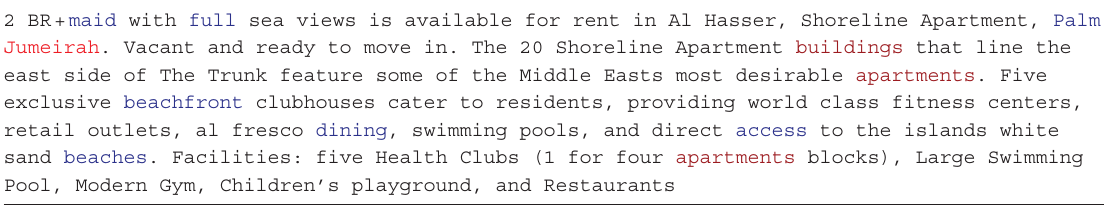
Table 1: Sample Classified with Important Words Highlighted. 2 BR + maid with full sea views is available for rent in Al Hasser, Shoreline Apartment, Palm Jumeirah. Vacant and ready to move in. The 20 Shoreline Apartment buildings that line the east side of The Trunk feature some of the Middle Easts most desirable apartments. Five exclusive beachfront clubhouses cater to residents, providing world class fitness centers, retail outlets, al fresco dining, swimming pools, and direct access to the islands white sand beaches. Facilities: five Health Clubs (1 for four apartments blocks), Large Swimming Pool, Modern Gym, Children’s playground, and Restaurants Words in red affect the price of the classified negatively, while words in blue affect the price positively. For example, the words Jumeirah and Palm represent two neighborhoods (in Dubai, United Arab Emirates), with the Palm being the much more prime